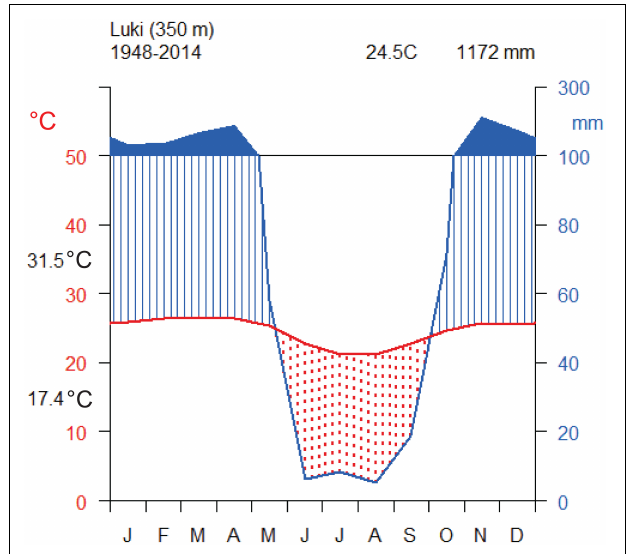
FIGURE 1 | Walter-Lieth climate diagram of the Luki Man and Biosphere Reserve from 1948 to 2014 (Data from the local climate station). The long dry season (in red) spans from June to September. 31.5 ◦ C and 17.4 ◦ C indicated on the y axis correspond to maximum and minimum annual